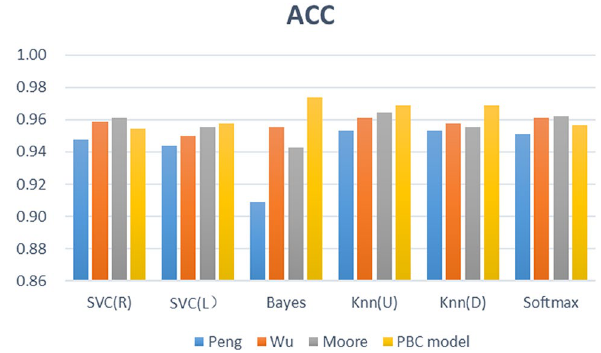
Figure 9. Accuracy of the four types of prediction models.